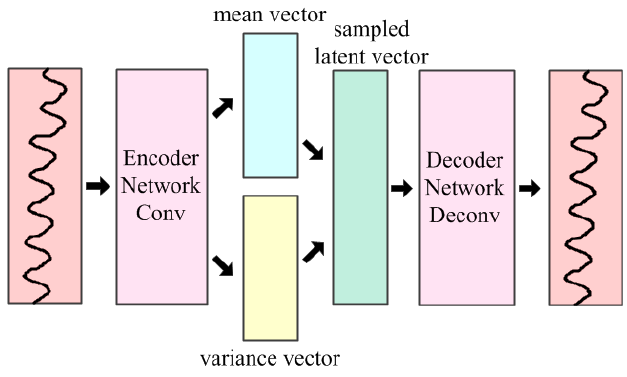
Figure 1. Structure of the VAE.